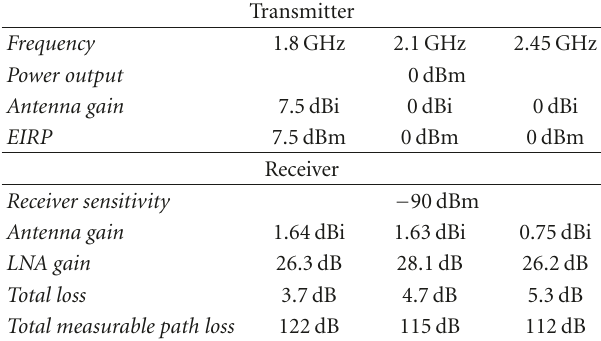
Table 1: Transmitter and receiver